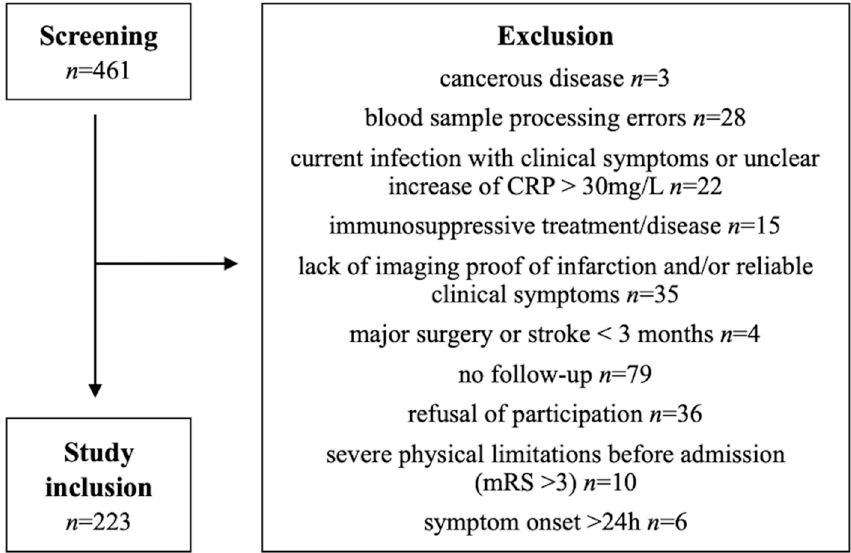
Figure 4. Selection flow chart with the reasons for the study exclusion.